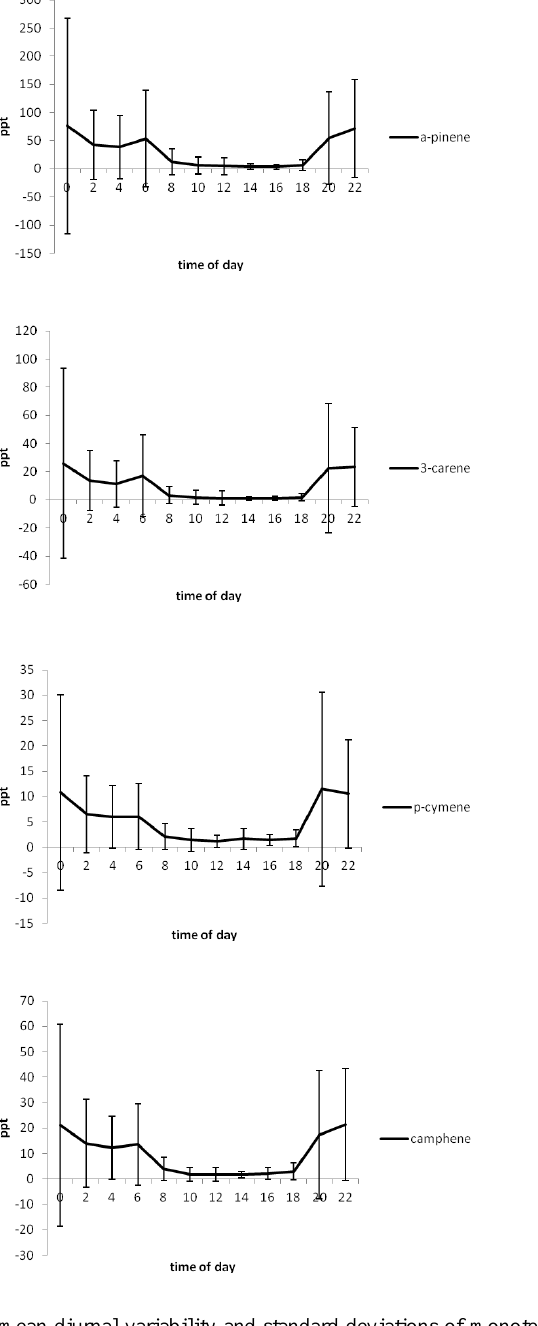
Fig. 7. The mean diurnal variability and standard deviations of monoterpenes in spring (April, May). March is not included in the figure, because mixing ratios then are more like winter mixing ratios, with no diurnal